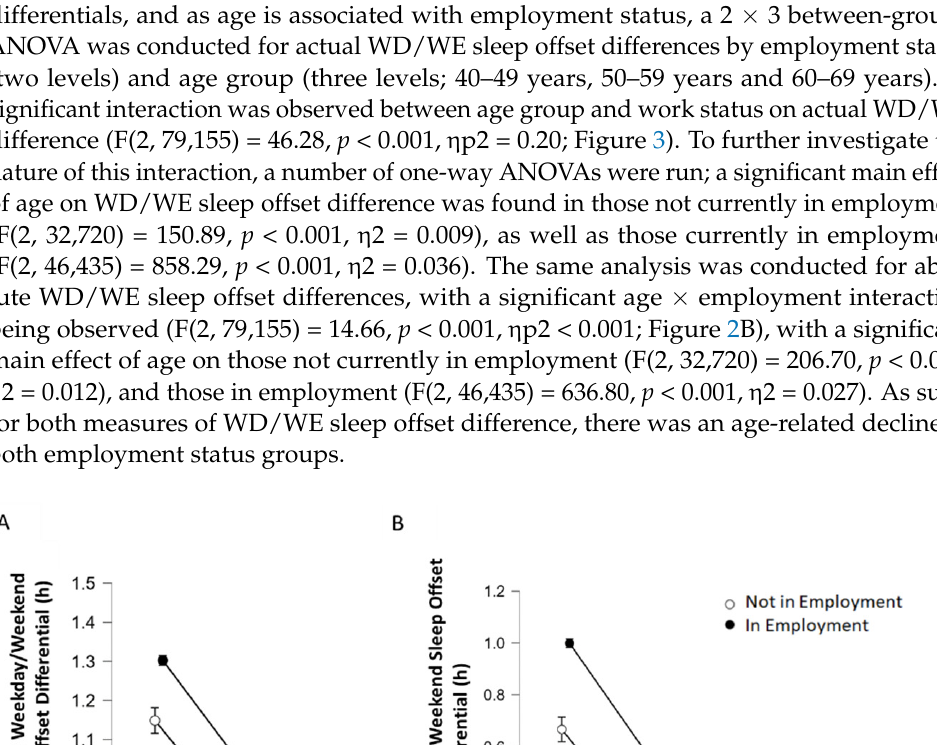
5 Figure 2. Box-and-violin plots showing ( A ) actual and absolute WD/WE in males and females; ( B ) actual and absolute WD/WE according to three age groups of participants (40 to 49 years old, 50 to 59 years old and 60 to 69 years old); and ( C ) actual and absolute WD/WE in participants currently